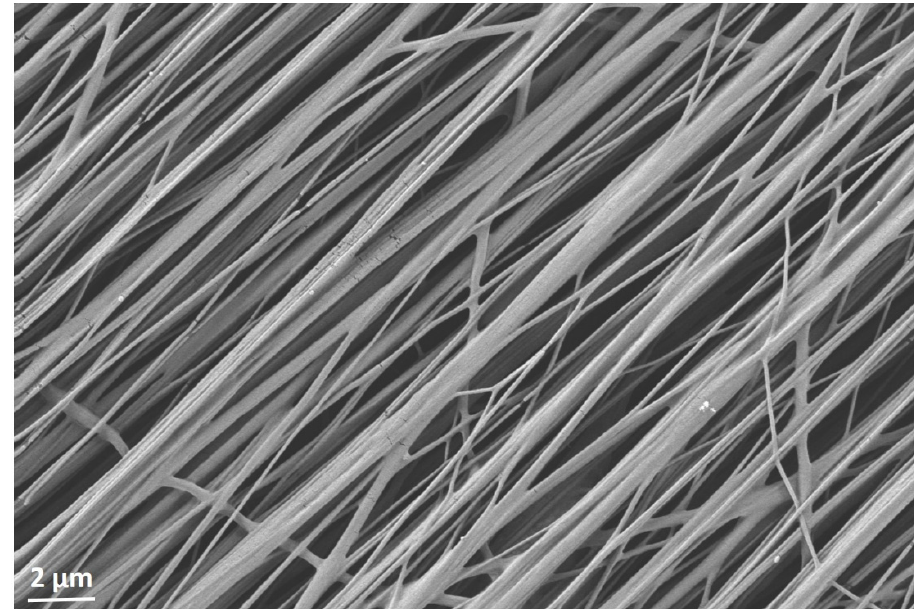
Figure 6. SEM image of electrospun aligned PCL-collagen I-nanofibers. Scale bar 2 µm.